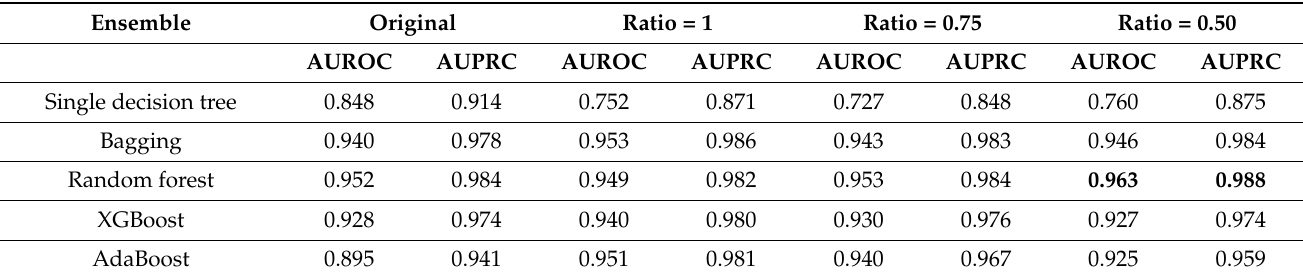
Table 5. The performance metric of ensembles (standard decision tree) along with oversampling method (SMOTE) of minority and majority class points for different ratios. AUROC and AUPRC performance metrics are considered for this experiment. (Best results are shown in bold numbers.).